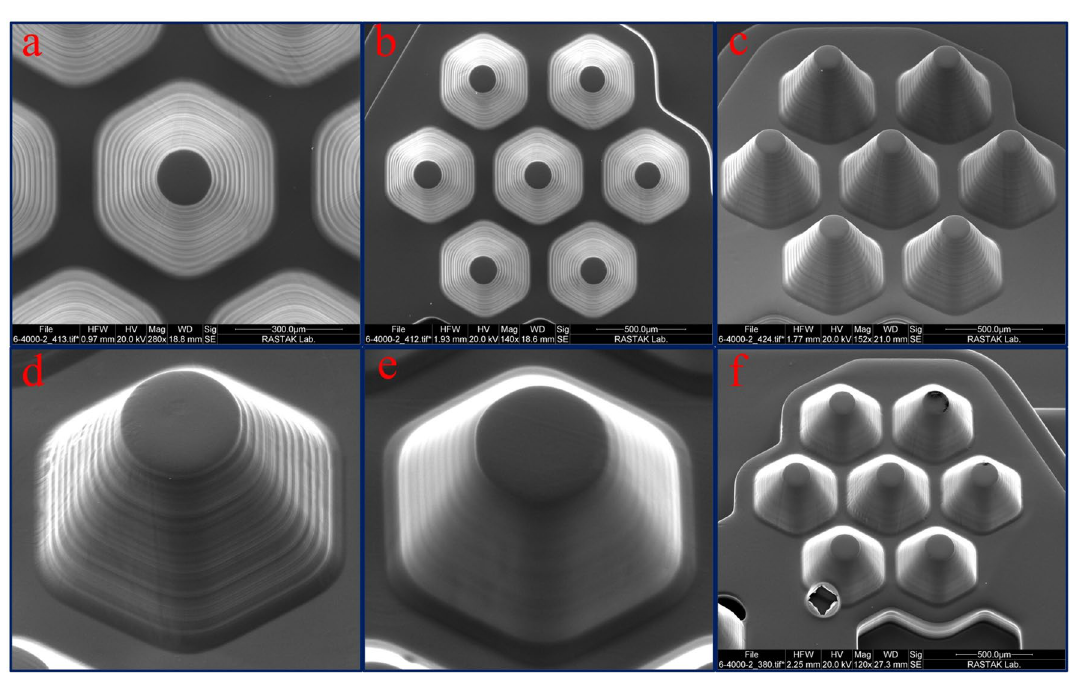
Figure 5. Scanning electron micrographs of the microwell molds. ( a ) Top view of a single 400 µm microwell mold. ( b , c ) Top and side views of microwells with a height of 400 µm. ( d , e ) Side view of a 300 µm microwell before and after PMMA coating. ( f ) An example of the failure in the PMMA layer causes by bubble